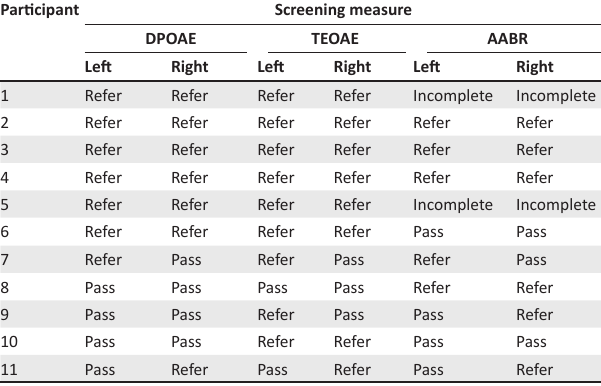
TABLE 1: Initial hearing screening result for each measure per participant.